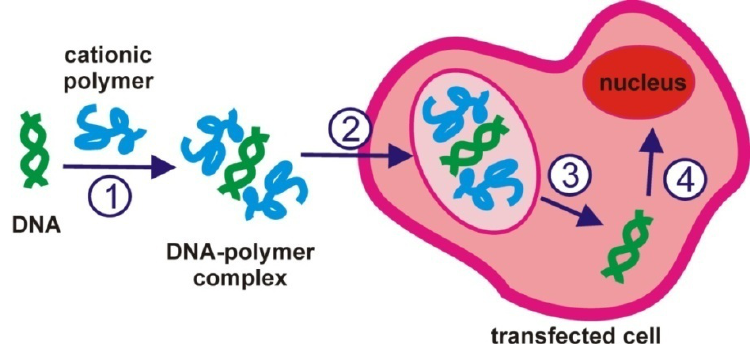
Figure 3. The main steps of gene delivery using a cationic polymer: ( 1 ) DNA complexation ( 2 ) complex traversing the cell membrane to the cytoplasm ( 3 ) DNA release into the cytoplasm and ( 4 ) DNA transfer into